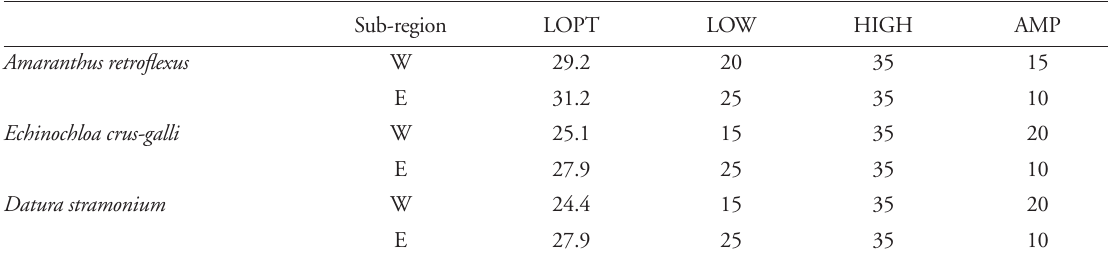
Table 3. Seed germination characteristics of A. retroflexus , E. crus-galli , and D. stramonium (for details cf. Fig. 2). W = western part of Kosovo, E = eastern part of Kosovo. In accordance with Olff et al. (1994): LOPT = optimal temperature for germination, LOW = lowest constant temperature with a germination rate of at least 5%, HIGH = highest constant temperature with a germination rate of at least 5%, AMP = range in degrees Celsius between HIGH and